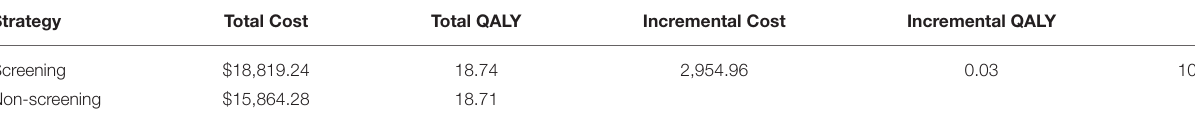
TABLE 4 | Summary findings of a cost-effectiveness analysis of thyroid cancer screening data.